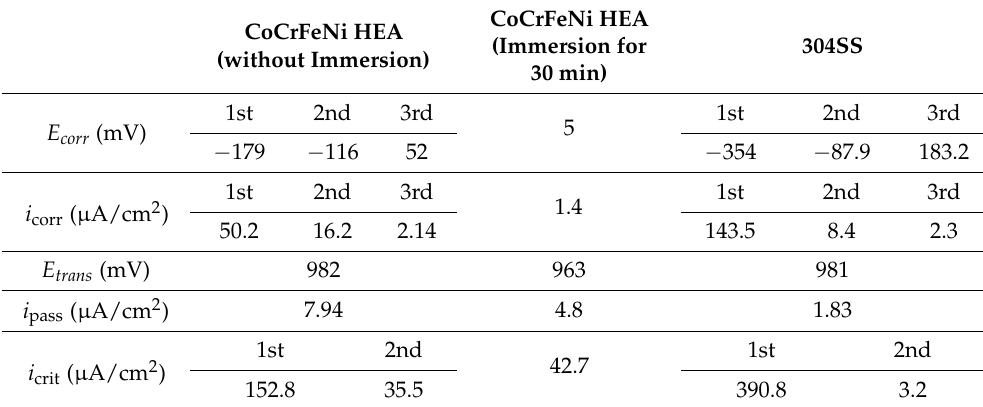
Table 3. The calculated reduction-oxidation equilibrium potentials of metal and metal hydroxides ( E eq ) by Equations (6)–(10) and that ( E’ eq ) of metal and metal ions by Nernst equation, assuming metal ions activity at 10 − 6 M at pH = 0.47 in 0.5 M H 2 SO 4 AAS for CoCrFeNi HEA and 304SS.